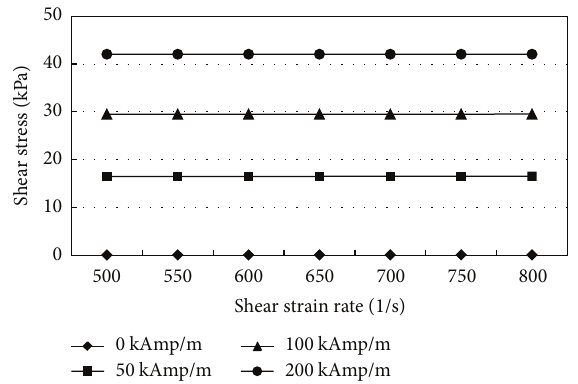
Figure 4: Shear transmission principle of MR fluid between two